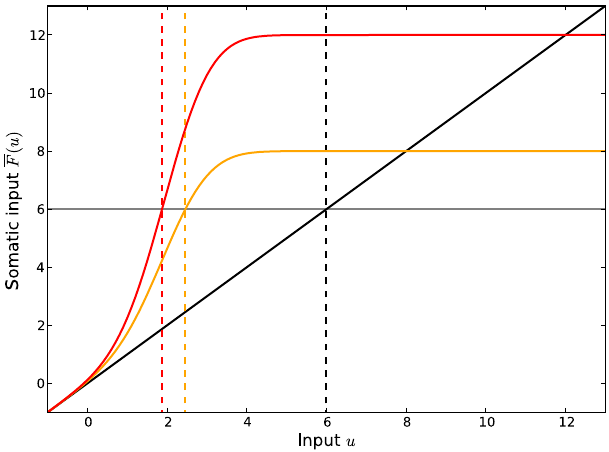
FIG. 3. Effective reduction of the neuronal threshold to ϑ ≤ Θ by nonlinear dendrites. The traditional, linear transfer function u (solid black line) crosses the threshold Θ ¼ 6 (solid gray line) at ϑ ¼ 6 (dashed black line). For B ¼ 2 , PN − 1 Var ½ w (cid:1) ¼ 0 . 8 , and θ ¼ 1 , dendritic nonlinearities ¯ F ð u Þ [Eq. (23)] with strengths D ¼ 4 (solid orange line) and D ¼ 6 (solid red line) lead to effective thresholds ϑ ≈ 2 . 5 (dashed orange line) and ϑ ≈ 1 . 9 (dashed red line),